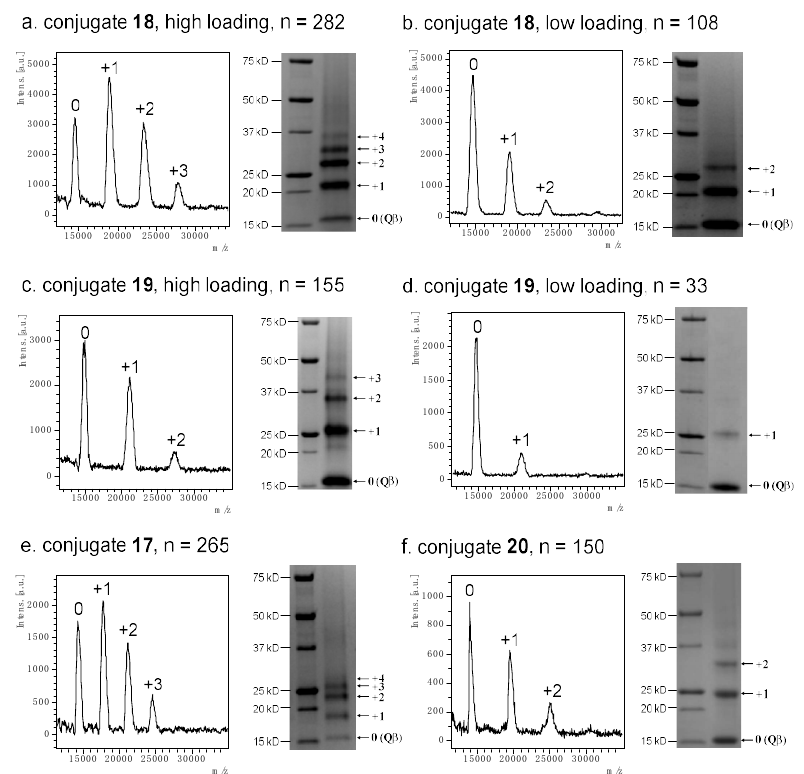
Figure 2. MALDI-TOF MS and reducing SDS-PAGE analysis of Q β -V1V2 glycopeptide conjugates 17 – 20 ( a ), conjugate 18 with high loading; ( b ), conjugate 18 with low loading; ( c ), conjugate 19 with high loading; ( d ), conjugate 19 with low loading; ( e ), conjugate 17 with high loading; ( f ), conjugate 20 with high loading.